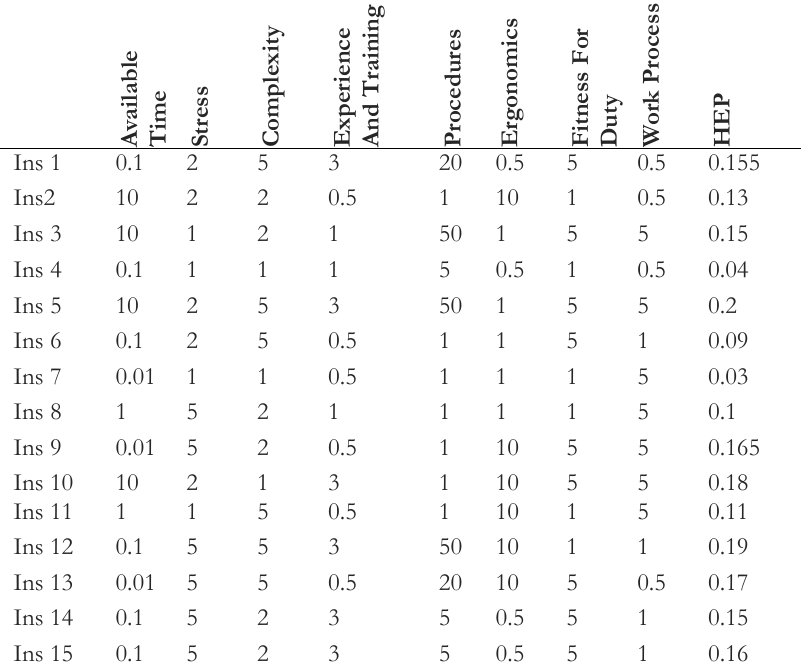
Table 2. Instances detail